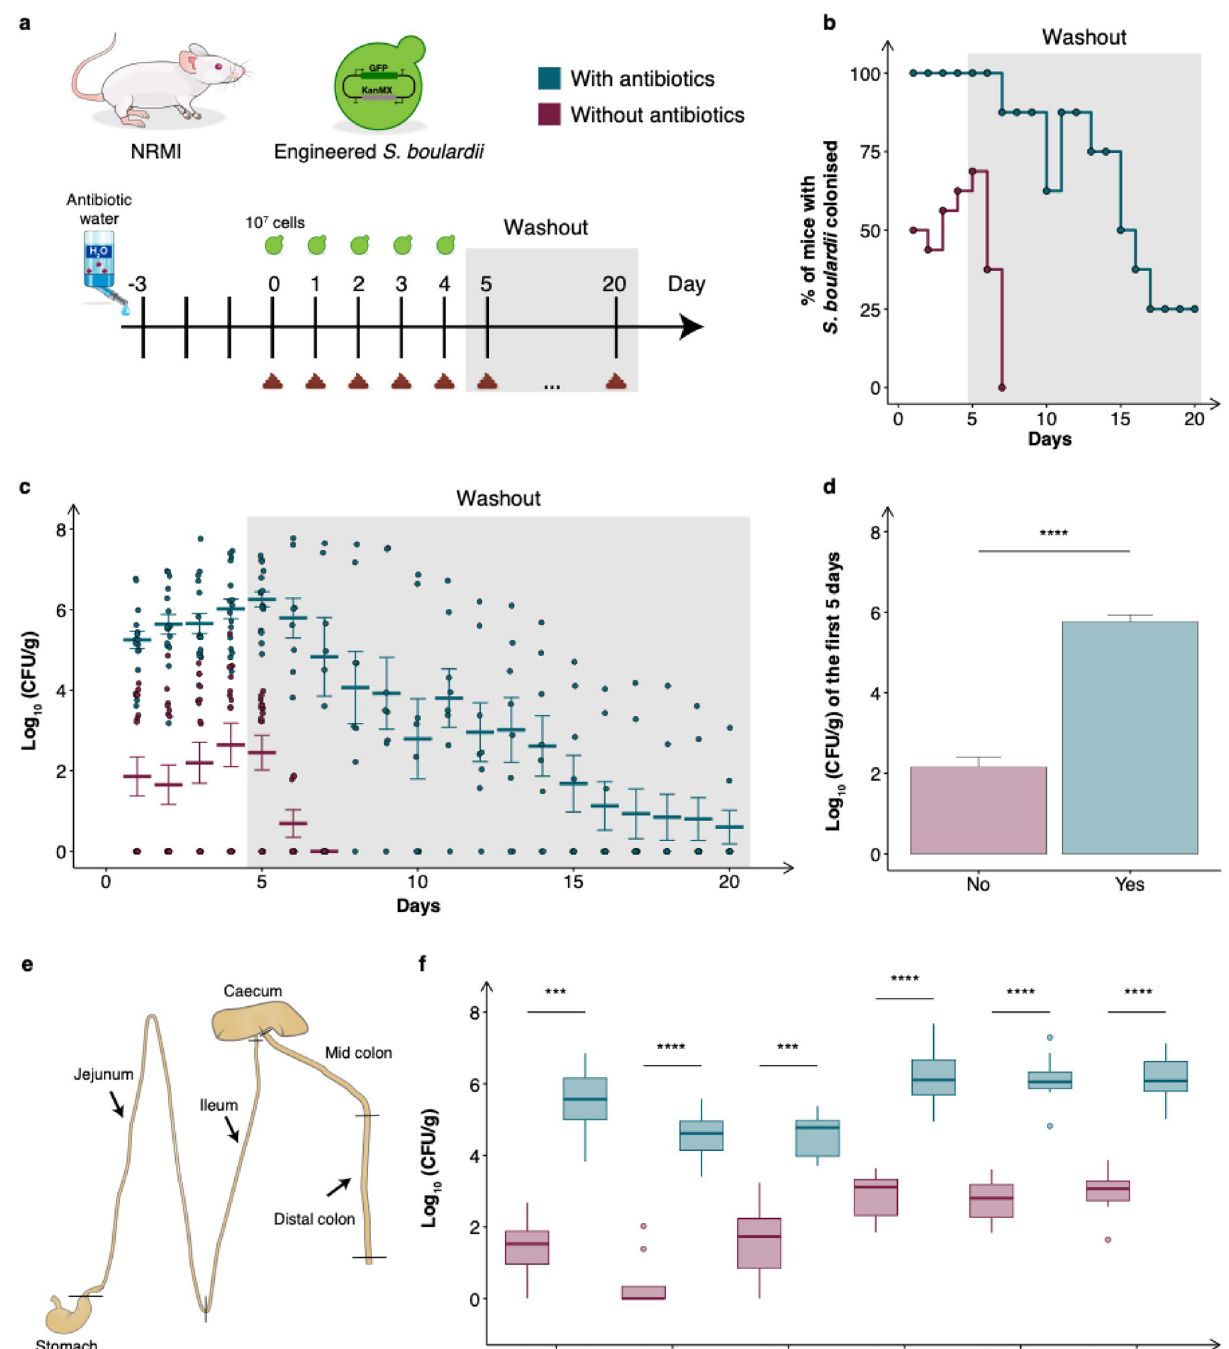
Figure 1. Colonisation assessment of S. boulardii in antibiotic-treated mice. ( a ) A graphical scheme of the study design. The mice were orally administered ~ 10 7 cells of S. boulardii daily for five successive days, followed by a 15-day washout period (grey shaded area). The mice were divided into two cohorts, where one received antibiotics supplemented in the drinking water. On the fifth day, half of the mice were sacrificed to determine the colonisation of S. boulardii in different gut regions. ( b ) The step plot shows the time-course of percentage of mice with detectable levels of S. boulardii in the antibiotic-treated cohort (blue) and the none-antibiotic- treated cohort (red). ( c ) The time-course of the log 10 mean CFU/g of S. boulardii ± SEM mean over time (days) in faeces. Each dot represents the log 10 CFU/g S. boulardii in one mouse. ( d ) Bar plot of the mean CFU/g of S. boulardii assessed in the faeces over the first five days. ( e ) A graphical illustration of the different gut regions investigated and how the regions were defined as marked. ( f ) Box plot of the assessed CFU/g of S. boulardii in the gastrointestinal tract from the nonantibiotic-treated and antibiotic-treated mice sacrificed on the fifth day. * p < 0.5, ** p < 0.1, *** p < 0.01, **** p < 0.001. All samples were analysed by a dependent sample